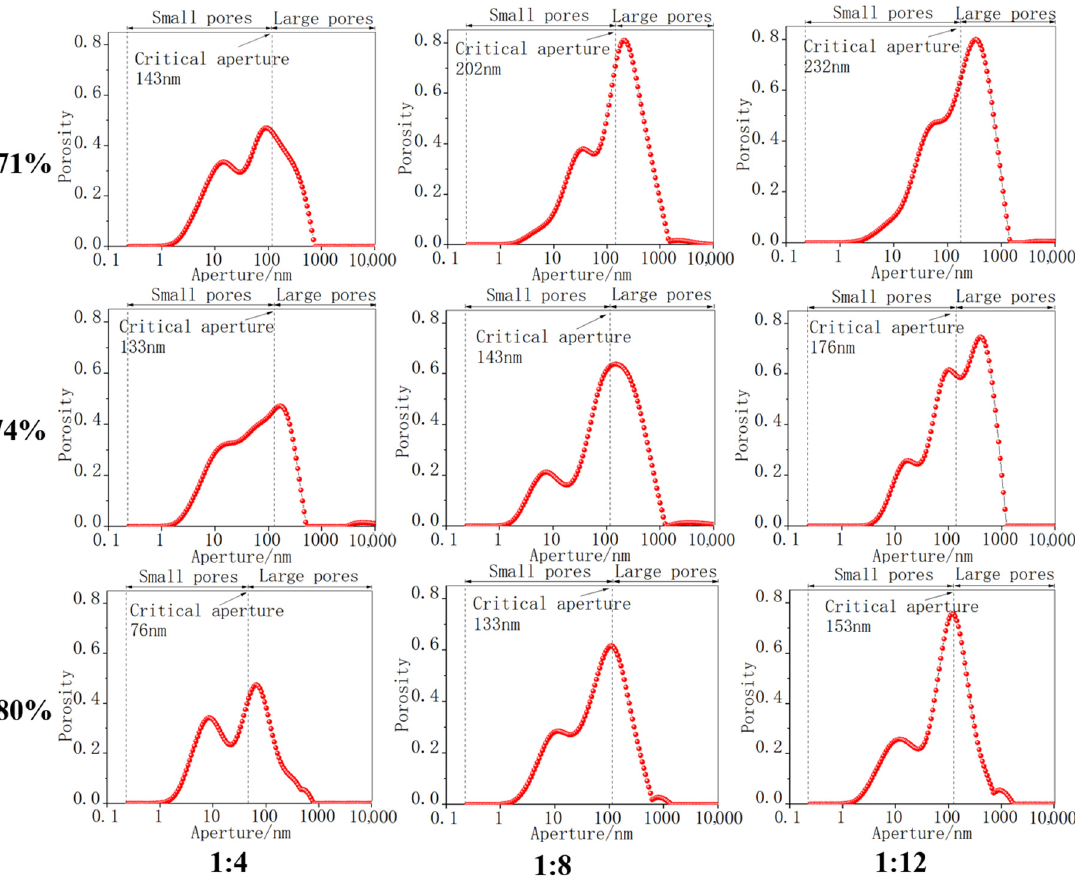
Figure 12. Analysis and distribution of porosity and the critical pore sizes of backfills with di ff erent concentrations and ratios.